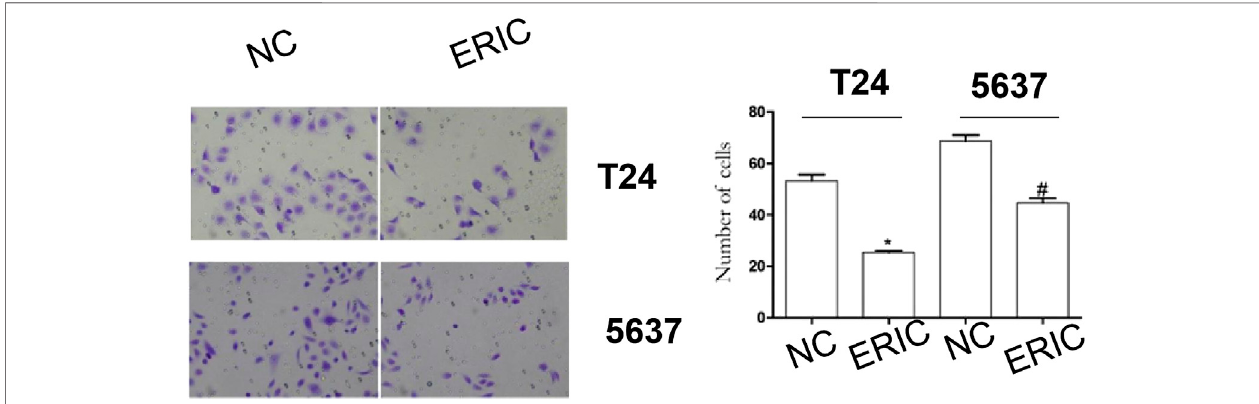
FIGURE 6 | Changes in cell invasion levels in each group (200 times). Cell invasion level was determined by transwell assay. The mean value ± SD was shown. * p < 0.05. # p < 0.05.